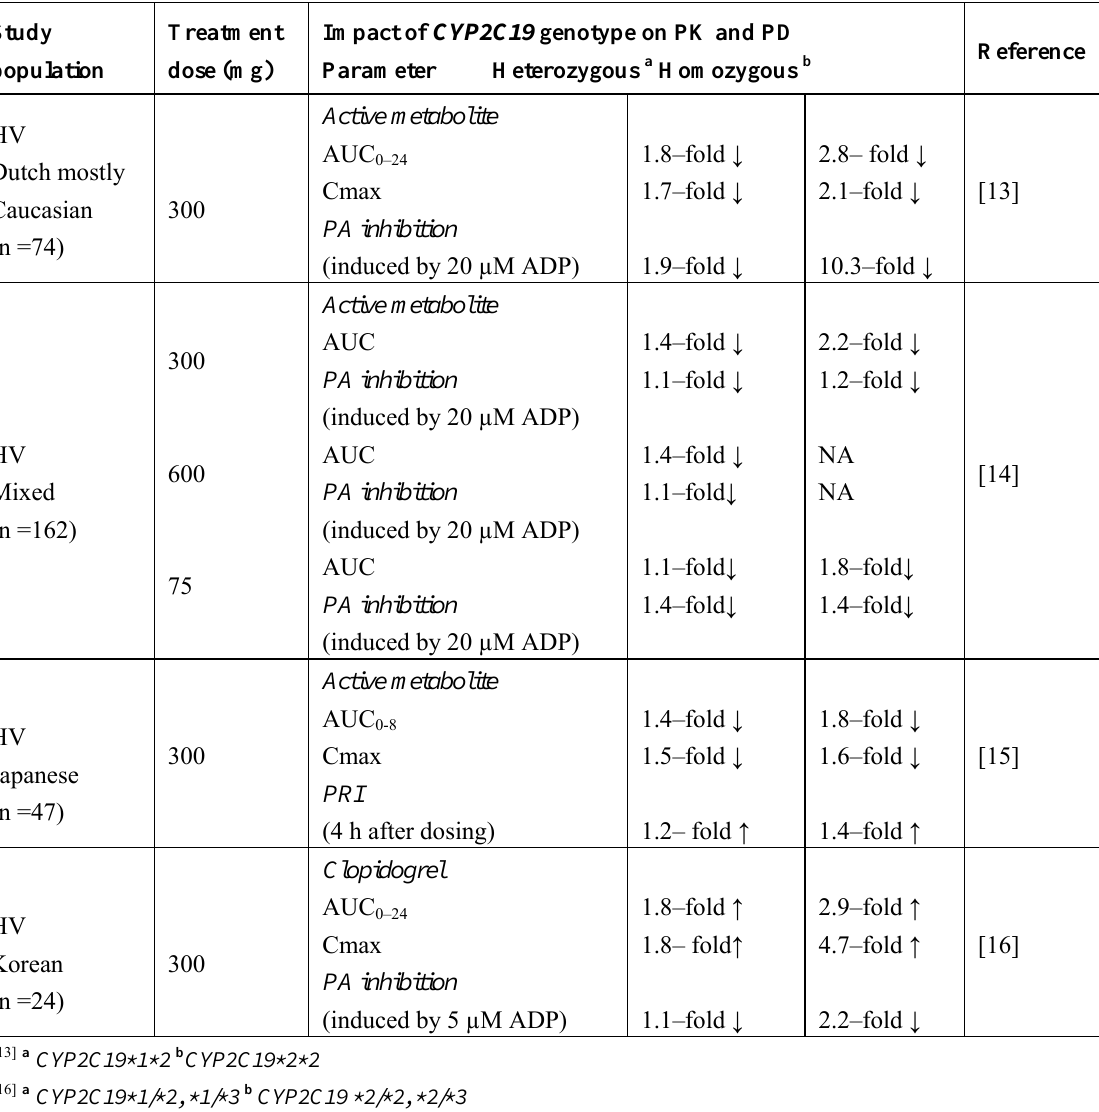
Table 1. The influence of CYP2C19 genotype (heterozygous or homozygous carriers of defect alleles compared to *1*1 genotype) on the pharmacokinetics (PK) and pharmacodynamics (PD) of